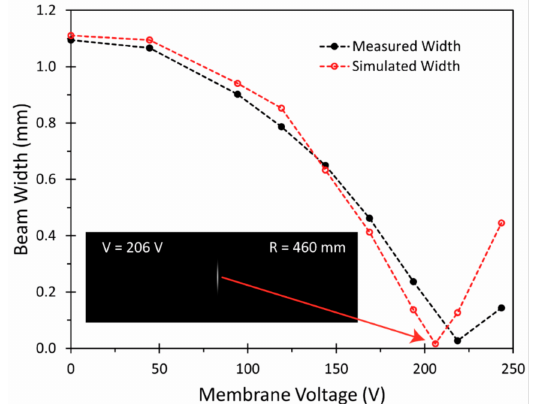
Figure 13. Comparison of measured and simulated beam widths w for varying membrane voltages. For the clarification of the trend in the simulated widths, an additional simulation point at 206 V membrane voltage, corresponding to mirror radius of 460 mm, is added. For illustration, the simulated beam profile with these parameters is inserted in the